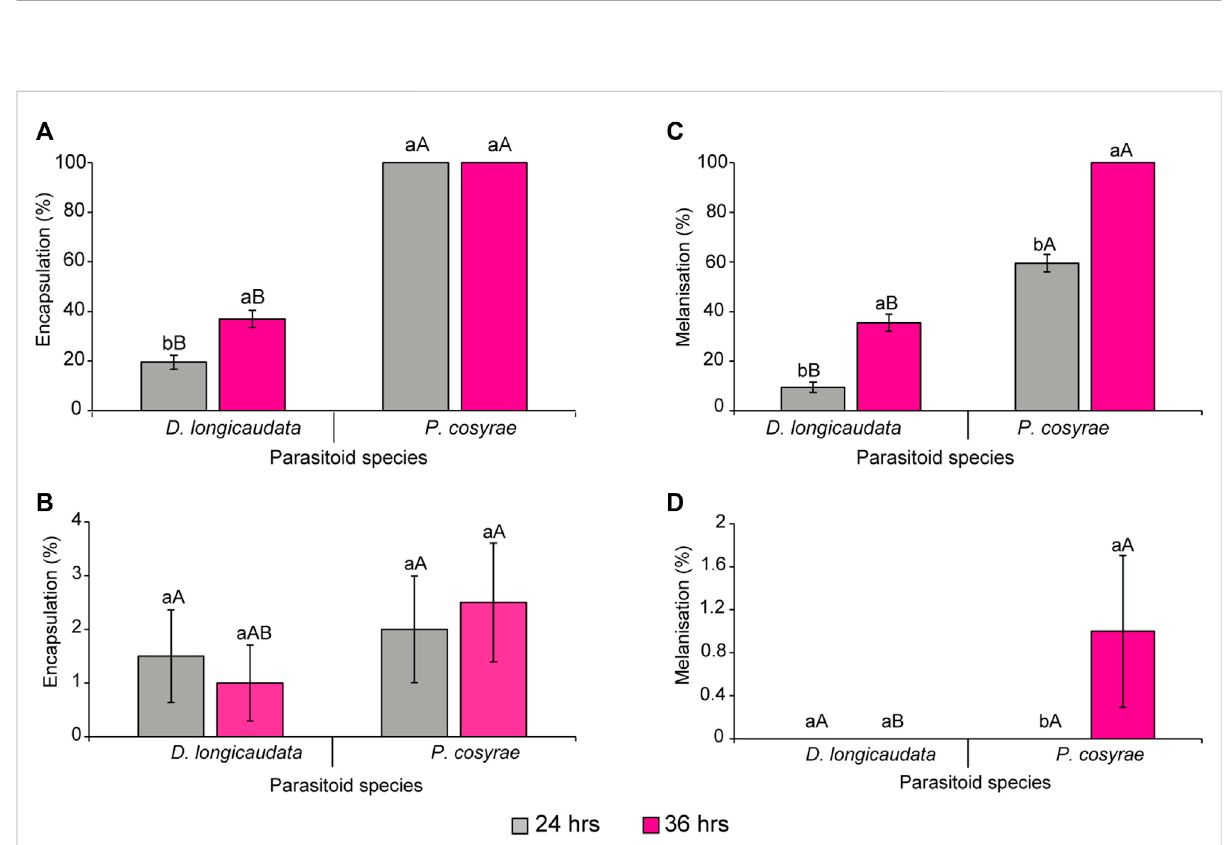
FIGURE 2 Encapsulation rates of (A) B. dorsalis and (B) C. cosyra , and melanisation rates of (C) B. dorsalis and (D) C. cosyra . Within the same parasitoid speciesgroupexposedtoeachhostfruit fl y,barscappedwithdifferentletters(lowercaselettersdenotedifferenceswithinthedifferenttimepointsof the same parasitoid group while upper case letters denote differences between the different parasitoids analyzed at the same time point) are statistically different (Tukey tests: p ≤ 0.05, n = 200). Error bars indicate ± standard error of the mean